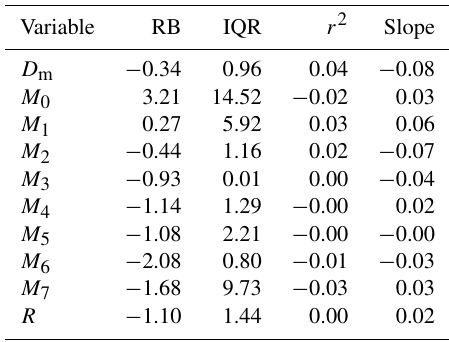
Table 4. Average differences between double-moment and SCOP- ME techniques, on Parsivel data, over three regions and four axis ra- tio functions. Negative values show an improvement by the double- moment technique over